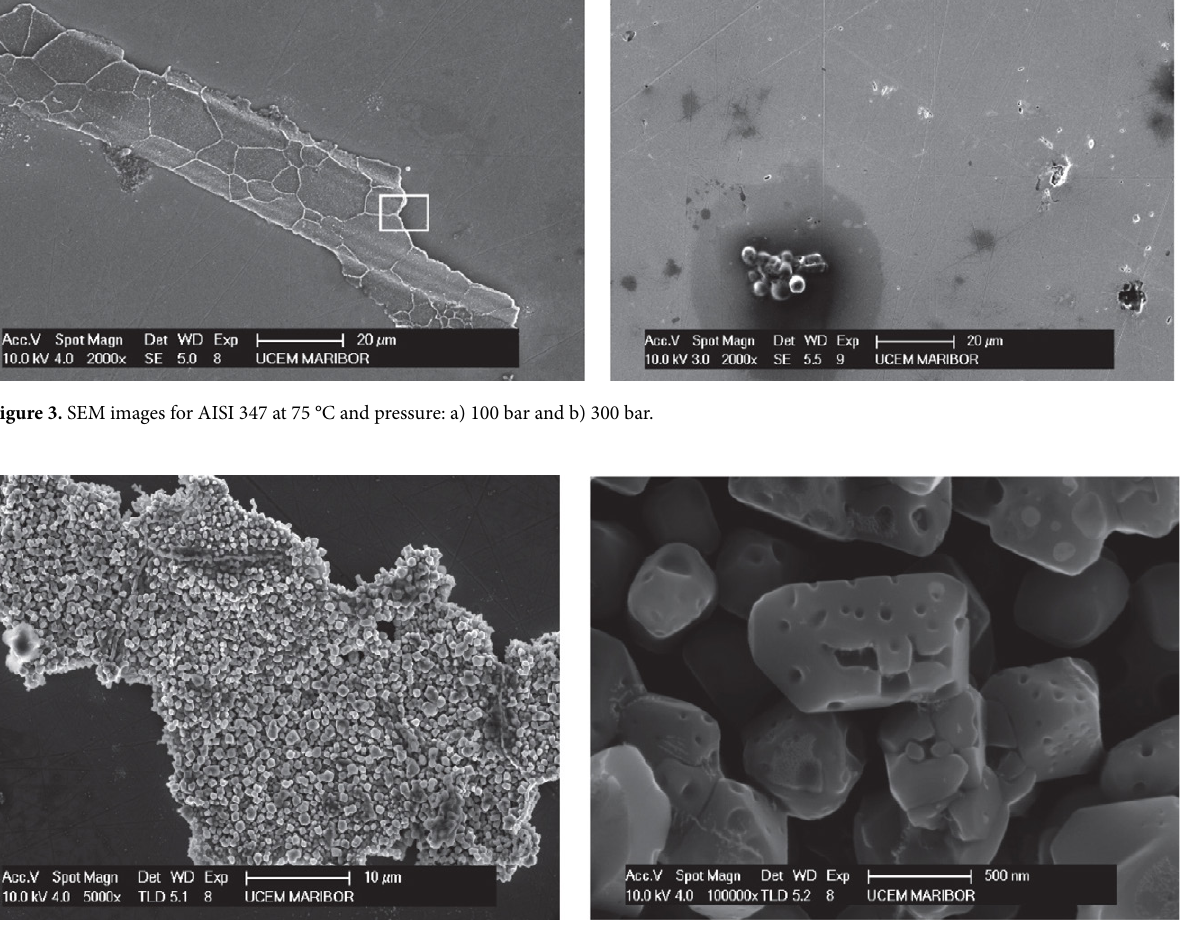
Figure 4. SEM images for AISI 347 at 75 °C and 100 bar at different magnifications (white borders from Figure